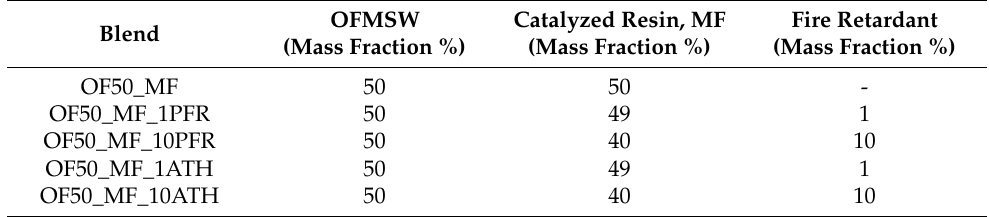
Table 1. Composition of the blends.